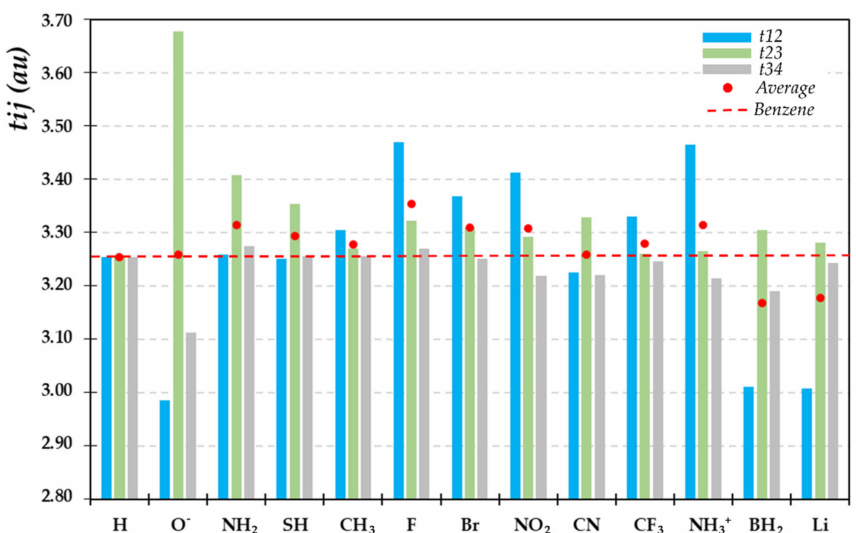
Figure 5. bij basin kinetic energies ( tij ) for a set of selected Ph–X systems. Notation as in Scheme 1. All data in au.